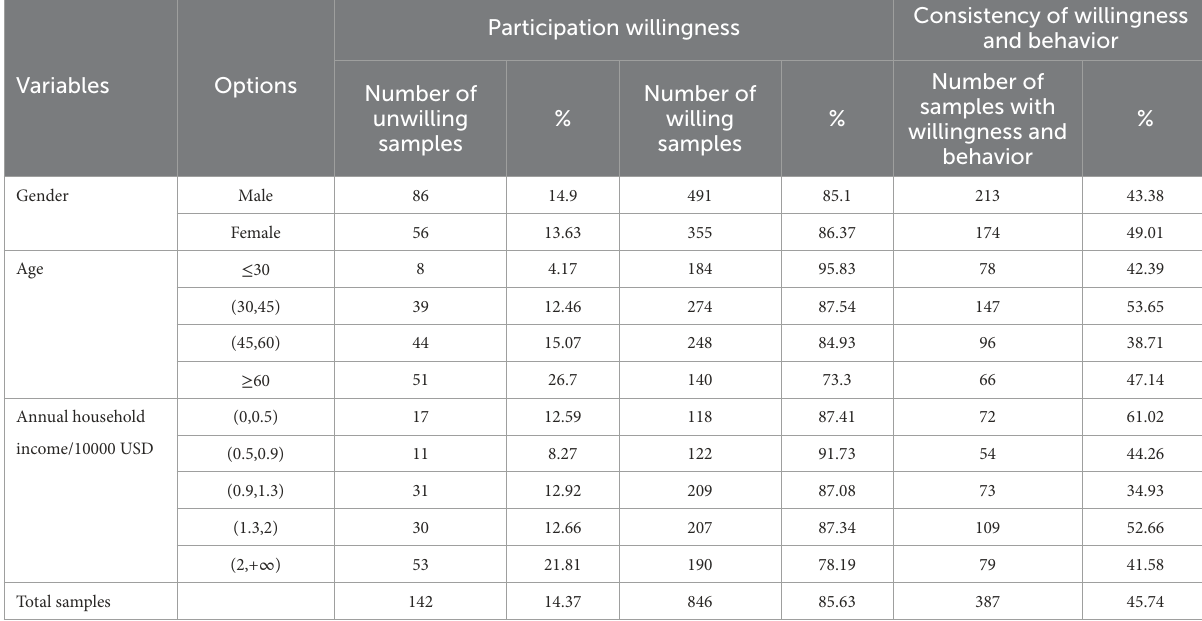
TABLE 3 Descriptive statistics of consistency of willingness and behavior.